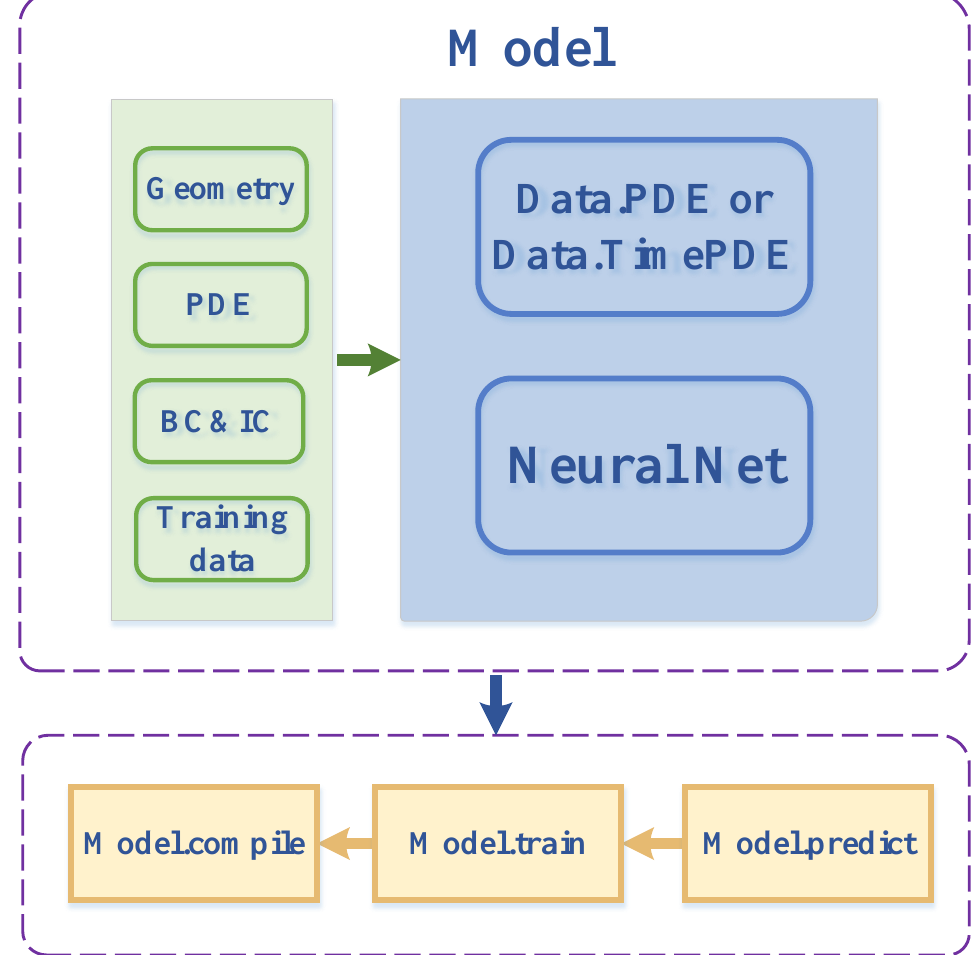
Figure 3. The workflow of DeepXDE. The green modules define the PDE and the training hyperpa- rameters. The blue modules combine the PDE and training hyperparameters. The yellow modules are the three steps to solve the